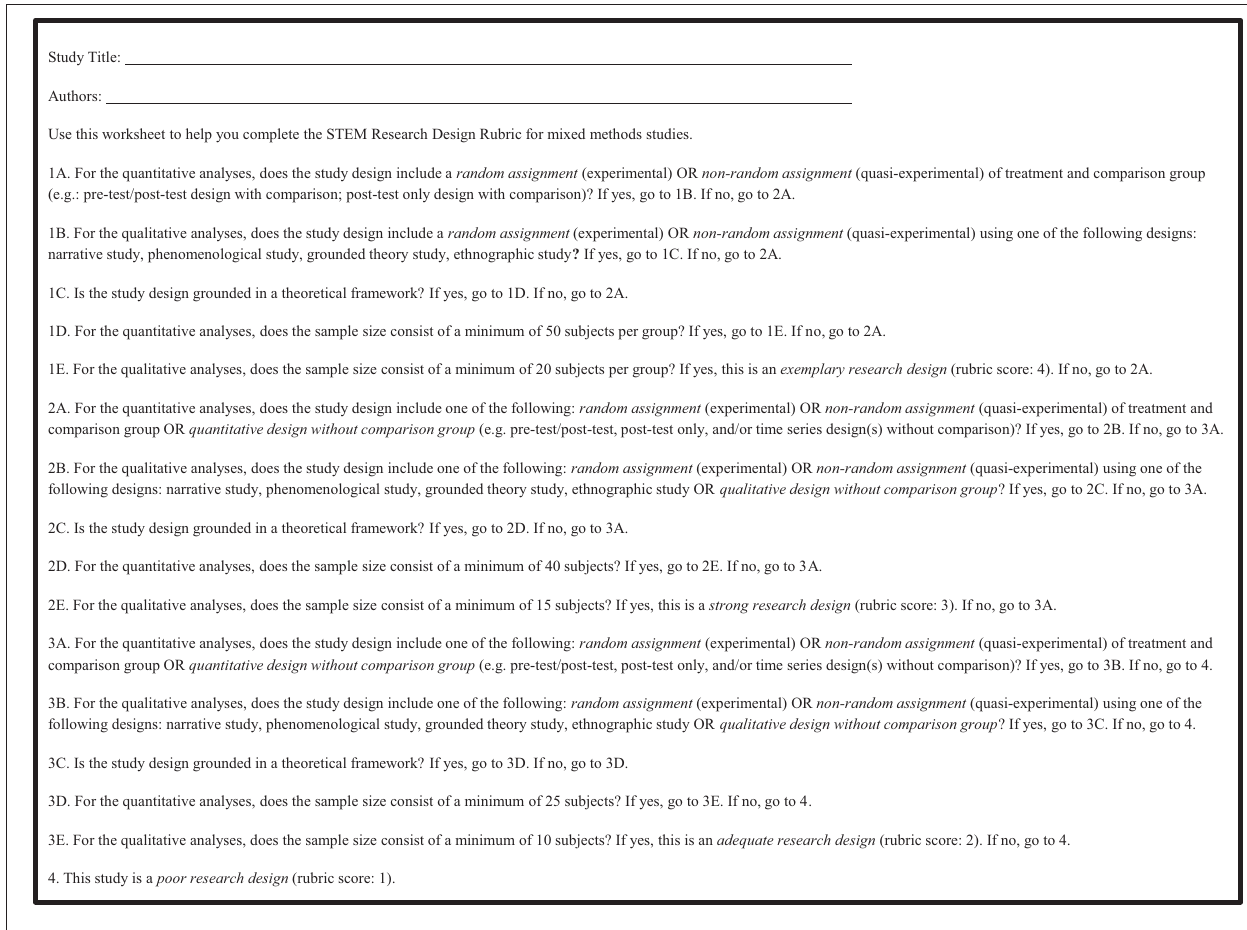
FIGURE 5 | STEM Research Design Rubric worksheet for mixed methods